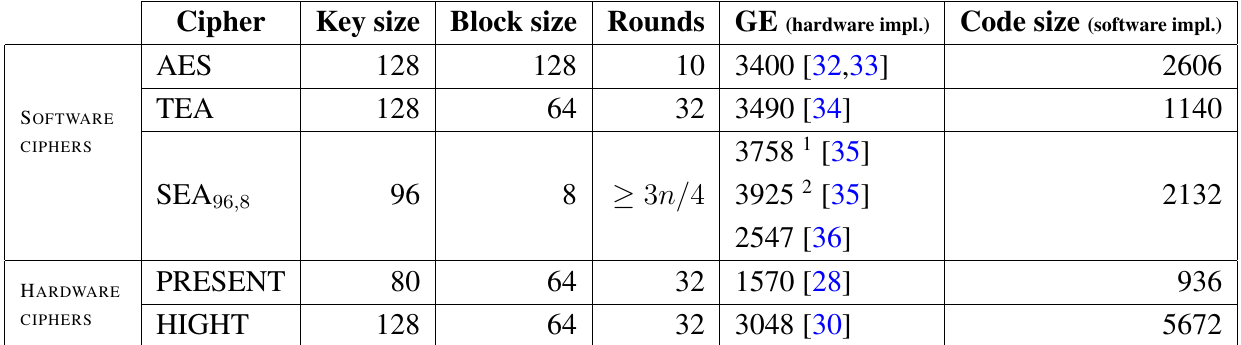
2547 [36] PRESENT 80 64 32 1570 [28] 936 HIGHT 128 64 32 3048 [30] CIPHERS